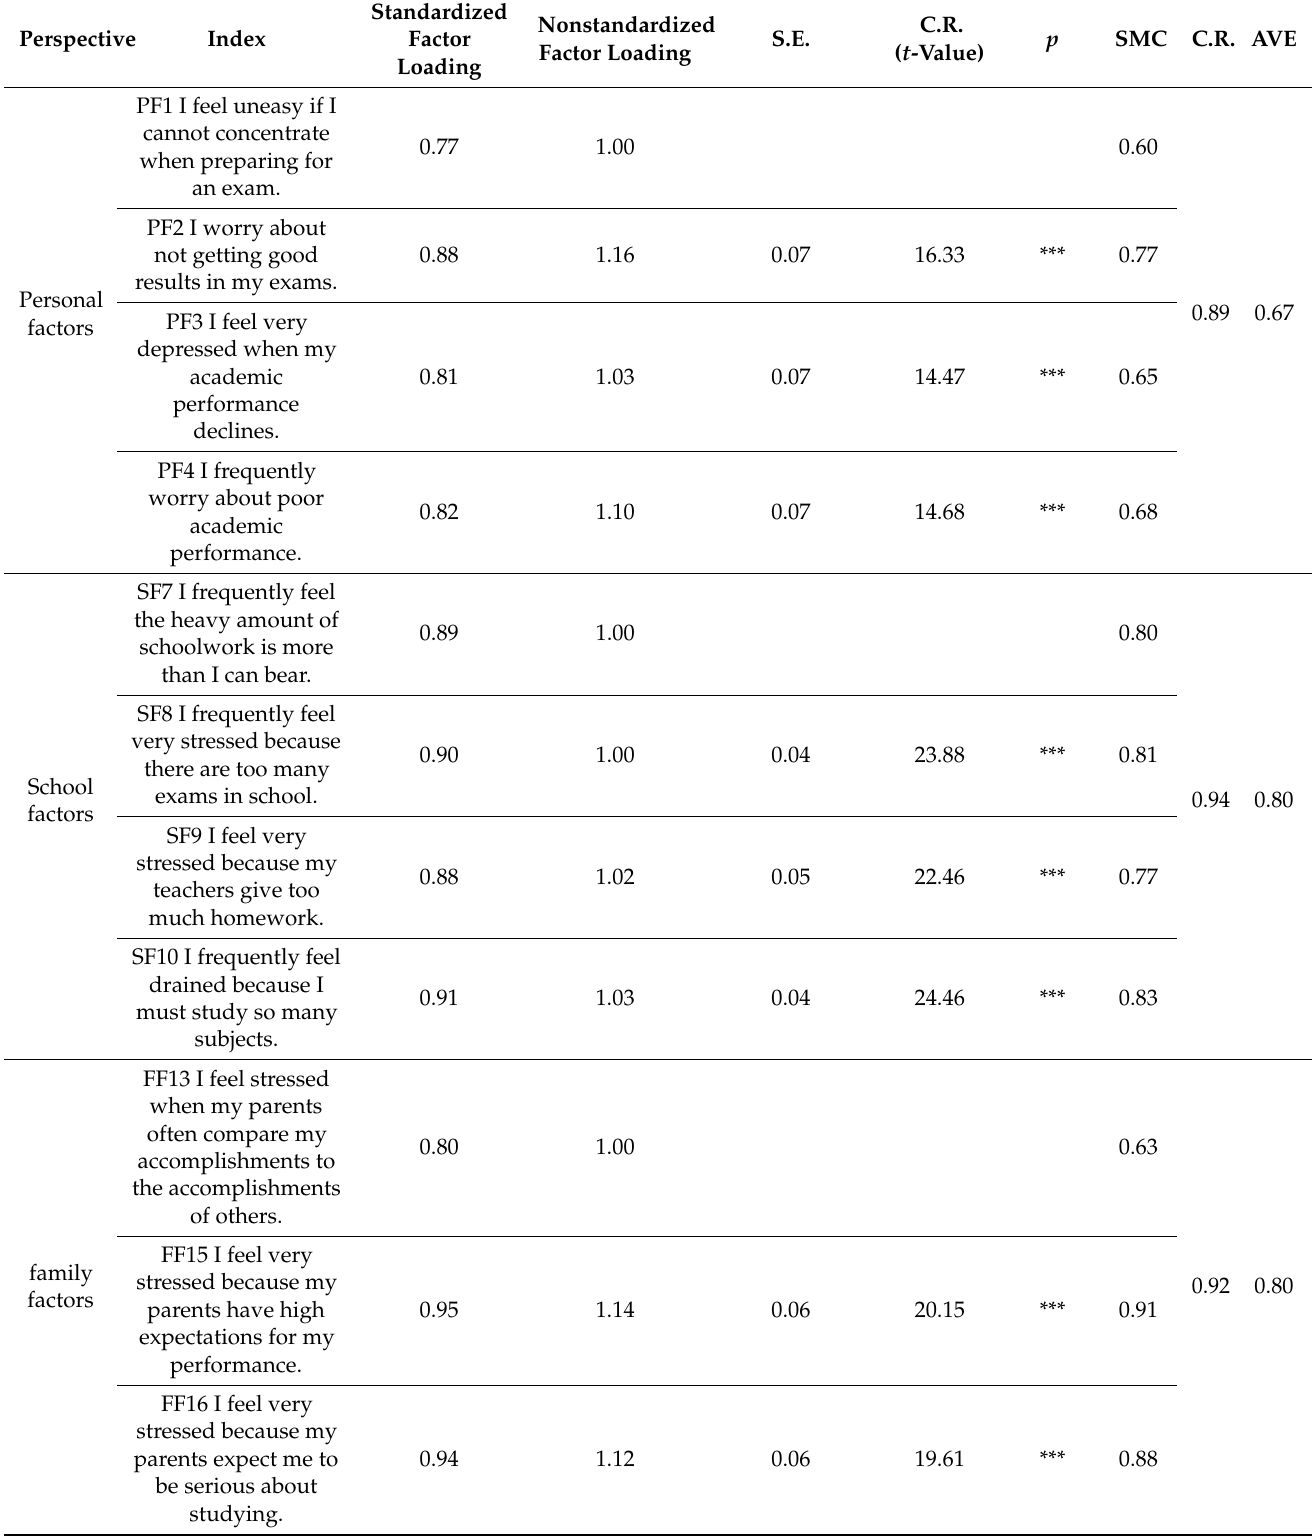
Table 3. Academic stress—confirmatory factor analysis reached a significant